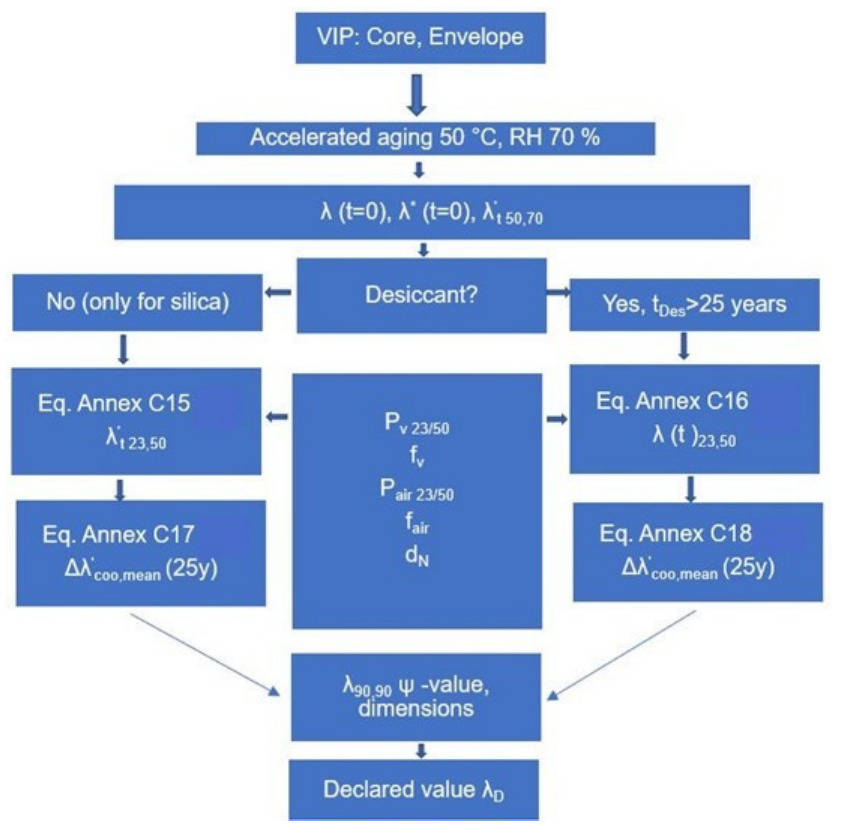
Figure 1. Ageing procedure according to EN 17140 [25].